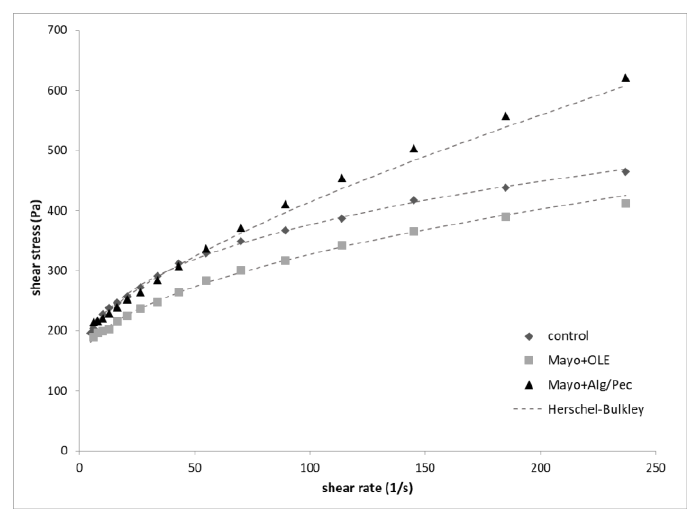
Figure 4. Flow curves of the mayonnaise after preparation.